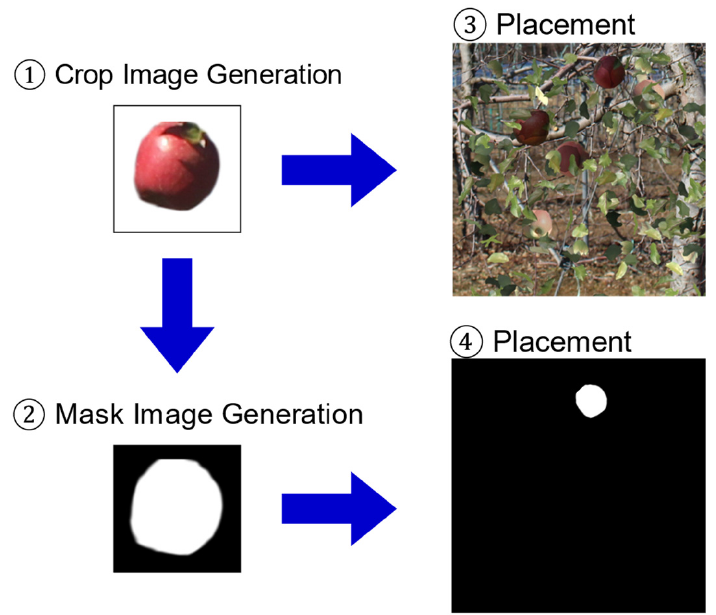
Figure 2. Generation process of synthetic images. First, fruit, leaf, and background images were manually cropped from actual farm images. Second, black-and-white mask images were created from the cropped fruit images to handle the shape information of the fruit. Third, fruit and leaf images were then pasted at random positions on the background image to generate a composite image of the canopy. Fourth, the generated fruit mask images were placed at the same position of the pasted fruit images on a black image, which was the same size as the background image. Table 1. Generation parameters. When placing the fruit and leaf images on a background image, the luminance, angle, magnification, and aspect ratio were randomly changed within an arbitrary range to increase the diversity of the training